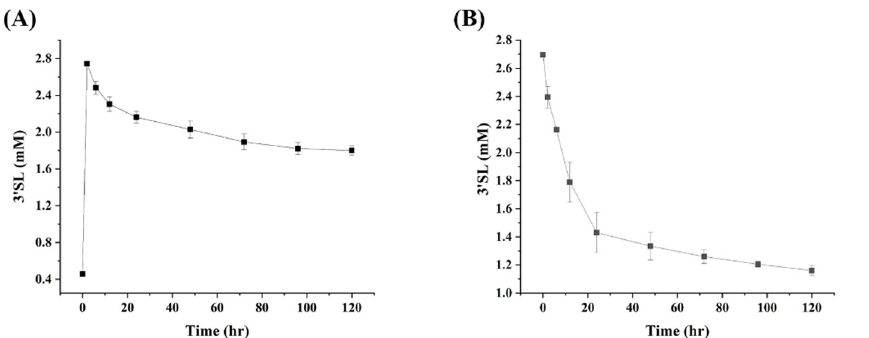
Figure 1. Analysis of α 2,3-sialyltransferase ( A ) and α 2,3-sialidase ( B ) activities of M144D by TLC. Lane 1, Lac; Lane 2, 0 h; Lane 3, 2 h; Lane 4, 6 h; Lane 5, 10 h; Lane 6, 24 h; Lane 7, 48 h; Lane 8, 72 h; Lane 9, 96 h; Lane 10, 120 h; Lane 11, S’-SL. Scheme 2. Enzymatic hydrolysis of 3 ′ -sialyllactose (3 ′ -SL) by PmST1. Scheme 2. Enzymatic hydrolysis of 3 (cid:48) -sialyllactose (3 (cid:48) -SL) by PmST1.